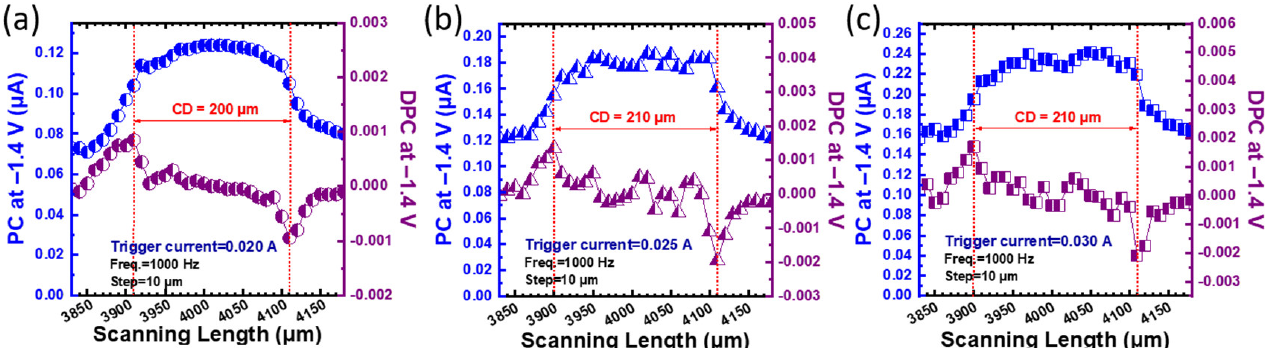
Figure 5. Photocurrent (PC) and differential photocurrent (DPC) versus scanning length curve for IGZO LAPS with a 200 μm-wide clear zone measured in pH 7 buffer solution at AC frequency at 1000 Hz with trigger currents of ( a ) 0.020, ( b ) 0.025 and ( c ) 0.030 A.